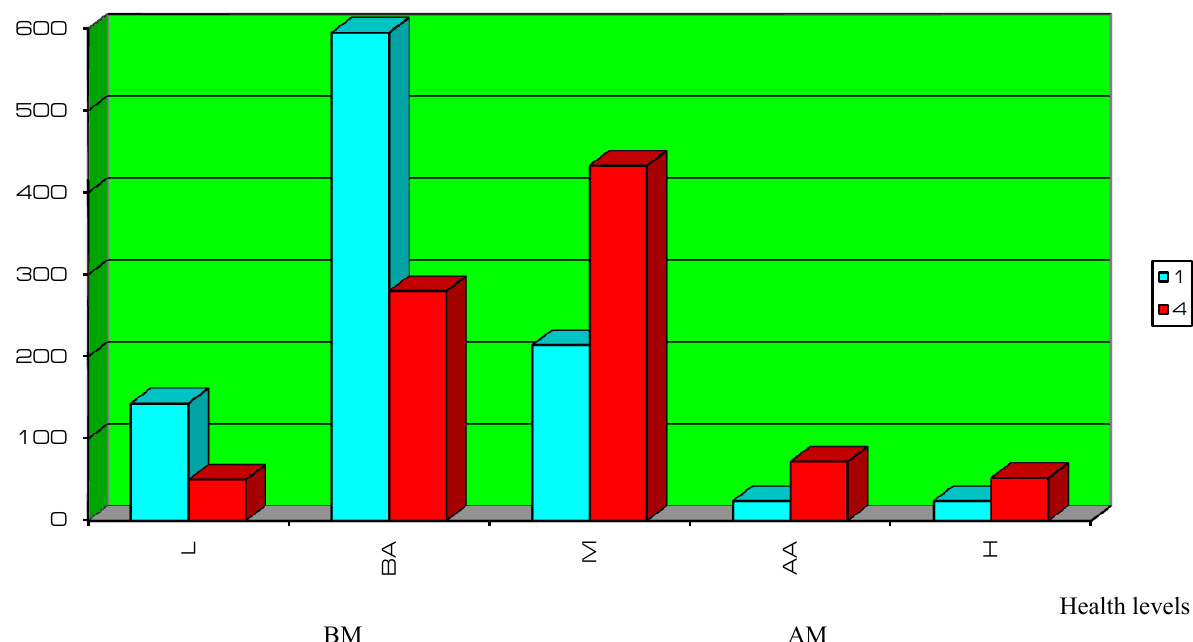
Fuig.2. Dynamic of somatic health of physical education students as per main indicators of organism’s life functioning (by methodic of G.L. Apanasenko,